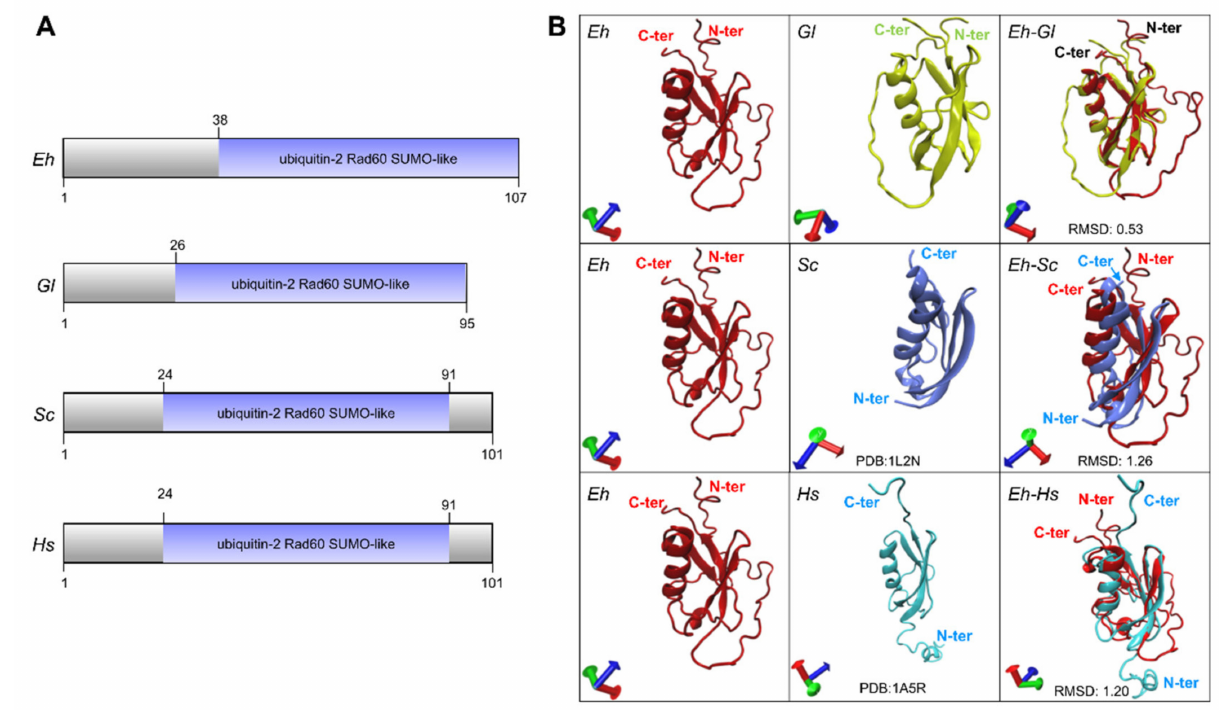
Figure 3. Secondary and tertiary structures of EhSUMO and its orthologous. ( A ) Schematic comparison of functional domains of EhSUMO and other SUMO proteins from different systems. Numbers at the right correspond to the amino acids forming each protein. ( B ) 3D-model of EhSUMO protein ( Eh ), overlapped with those of G. lamblia ( Gl ), S. cerevisiae ( Sc ), and H. sapiens ( Hs ). The N- and C-terminus regions are signaled in red letters. At the bottom of each square are indicated the predicted 3D structures used for G. lamblia and H.